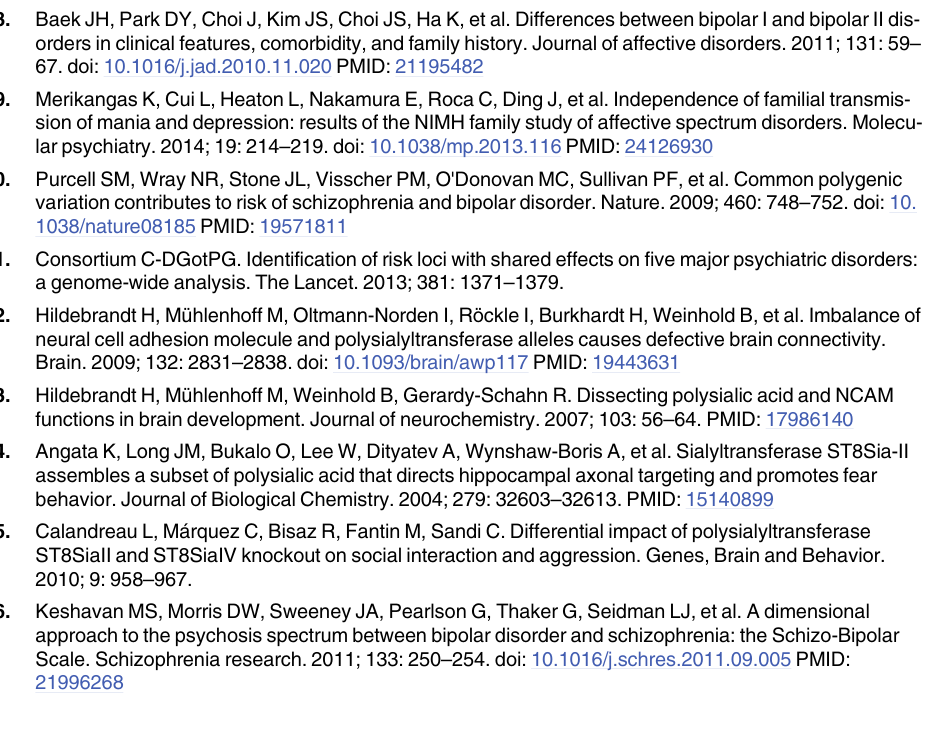
PLOS ONE | DOI:10.1371/journal.pone.0139413 September 29,